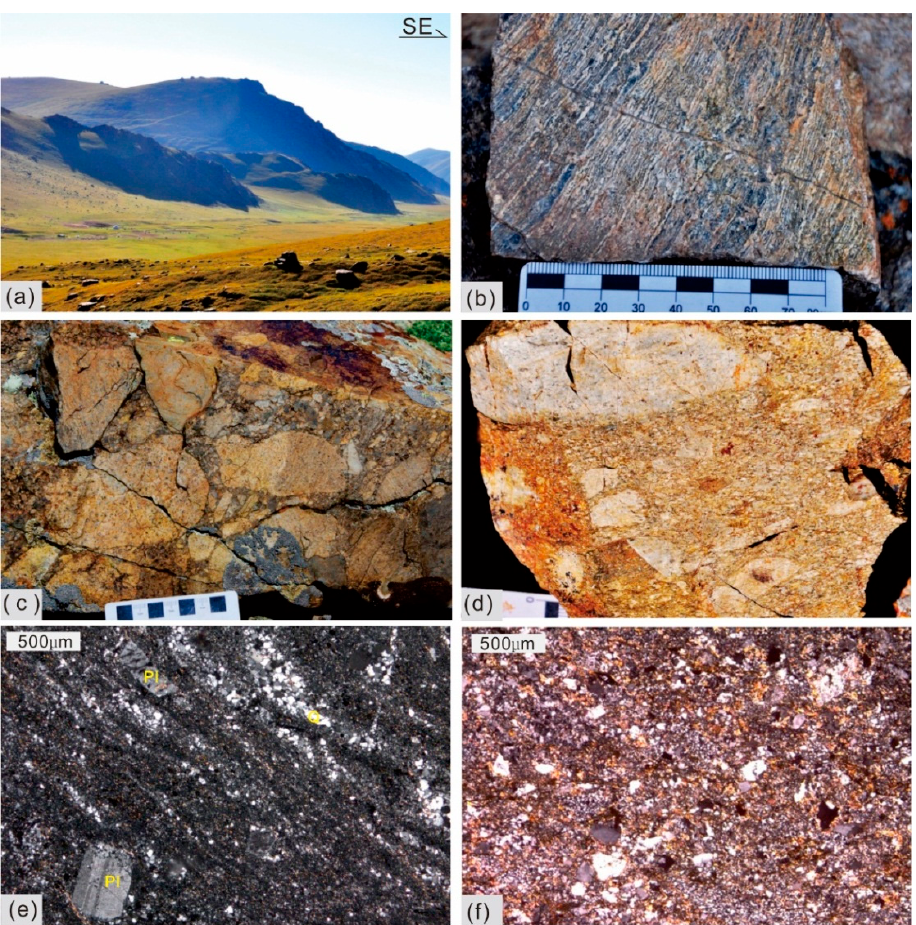
Figure 3. Field and microscopic photographs of the Early Devonian volcanic rocks. ( a ) Overview of the Early Devonian volcanic outcrop. ( b ) Fluidal structures in rhyolite samples. ( c ) Rhyolitic tuffs with rhyolitic gravel. ( d ) The mylonite structure in rhyolitic tuffs. ( e , f ) Microscope photographs of rhyolite and rhyolitic tuffs, respectively. Q: quartz, Pl: plagioclase.